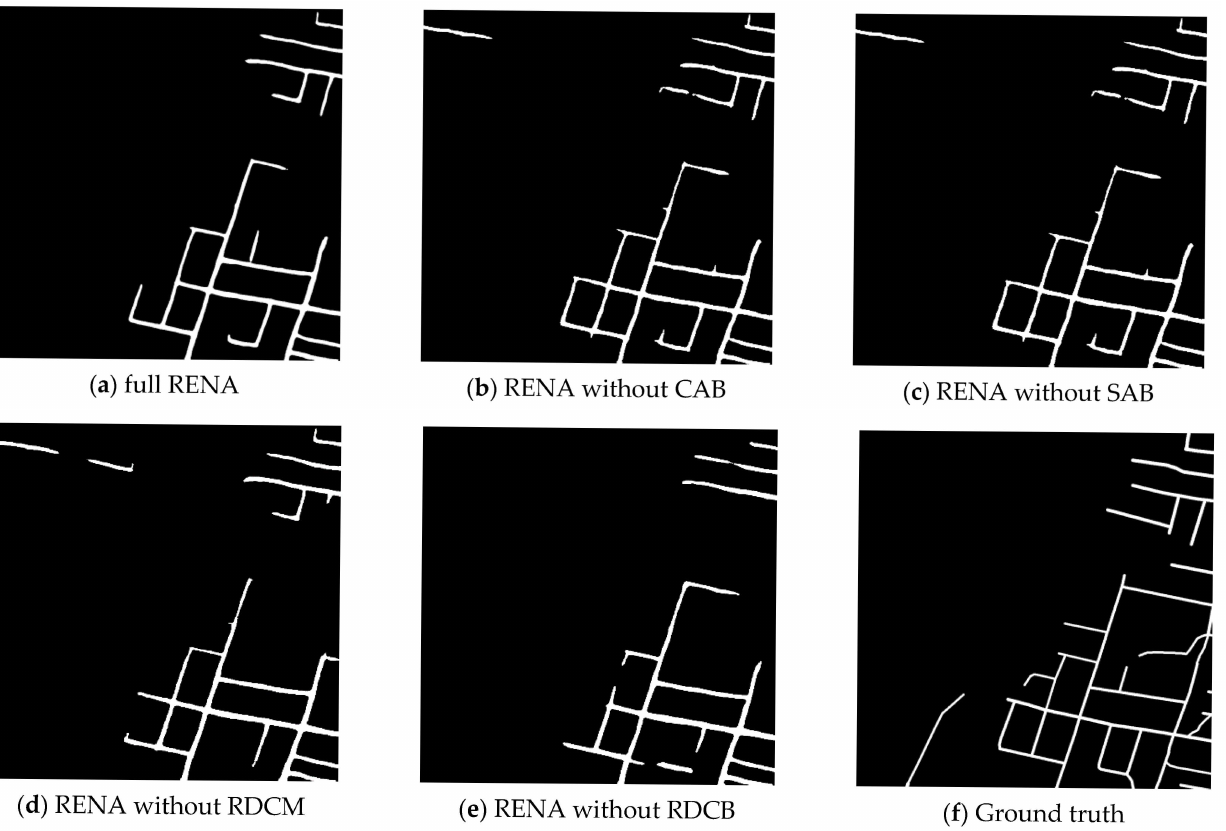
Figure 12. Visual evaluation results of the second group of sparse road